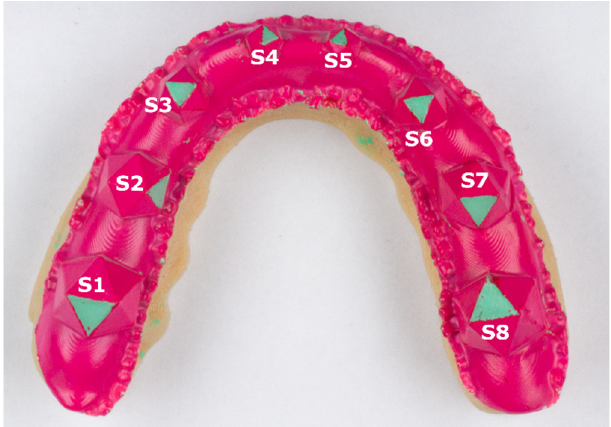
Figure 2. Example splint after “grinding surface” preparation and powder spraying. S1 to S8 depict the respective grinding surfaces.